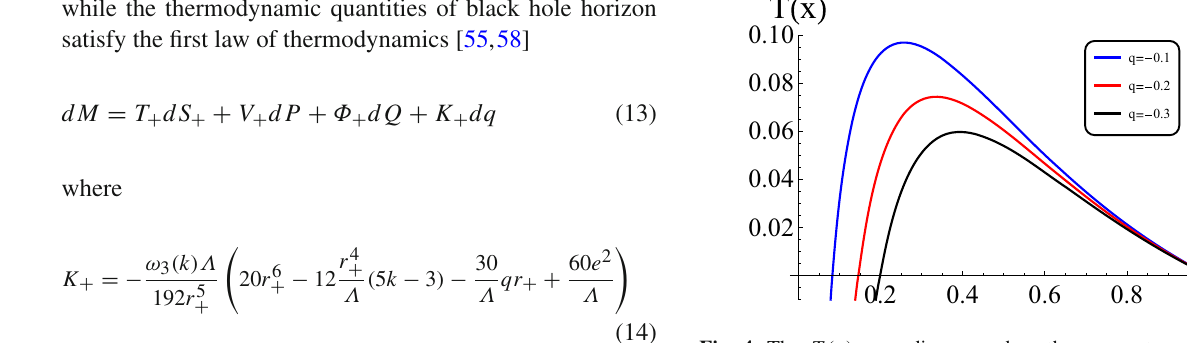
Fig. 4 The T ( x ) − x diagram when the parameter q is fixed at − 0 . 1 , − 0 . 2 , and − 0 . 3,